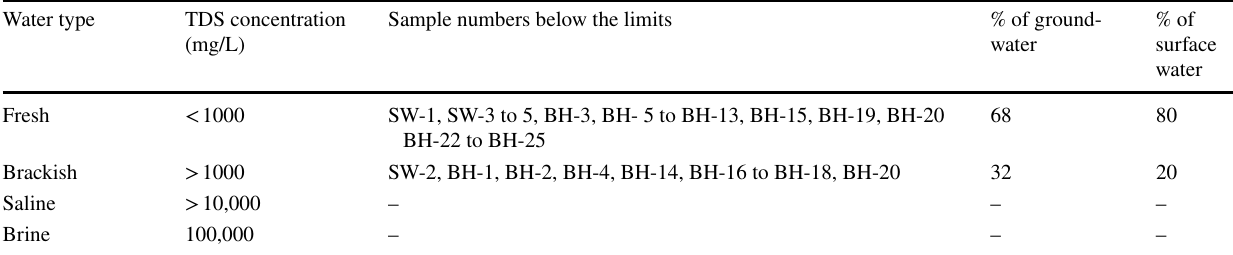
Table 4 Distribution of water samples based on the classification of TDS Water type